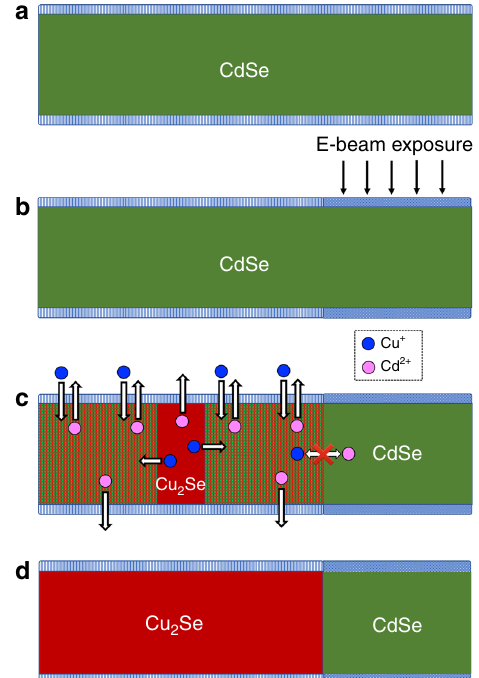
Fig. 1 Illustration of the masked cation-exchange process in single CdSe nanowires. The layer of surface ligands of a pristine CdSe NW ( a ) gets locally exposed to an electron beam that renders it impenetrable for cations ( b ). The CE reaction initiates in the unexposed regions and proceeds laterally until it reaches the interface with the e-beam irradiated region ( c ), which results in a heterojunction with an epitaxial sharpness ( d ). Cu + (Cd 2+ ) cations are sketched by blue (magenta) circles, and the arrows illustrate the diffusion